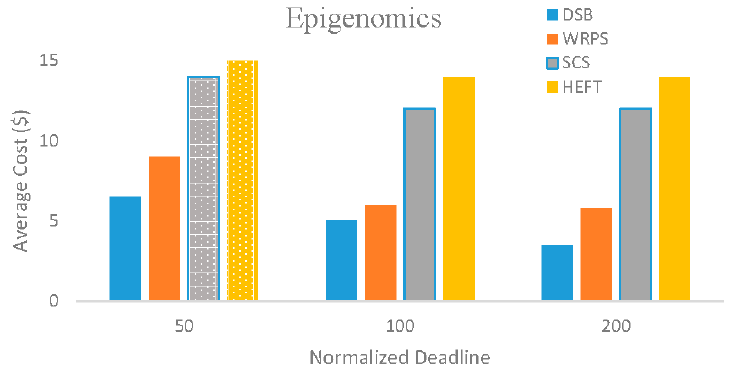
Figure 5. Average cost of Epigenomics under varied normalized deadline. Future Internet 2018 , 10 , x FOR PEER REVIEW